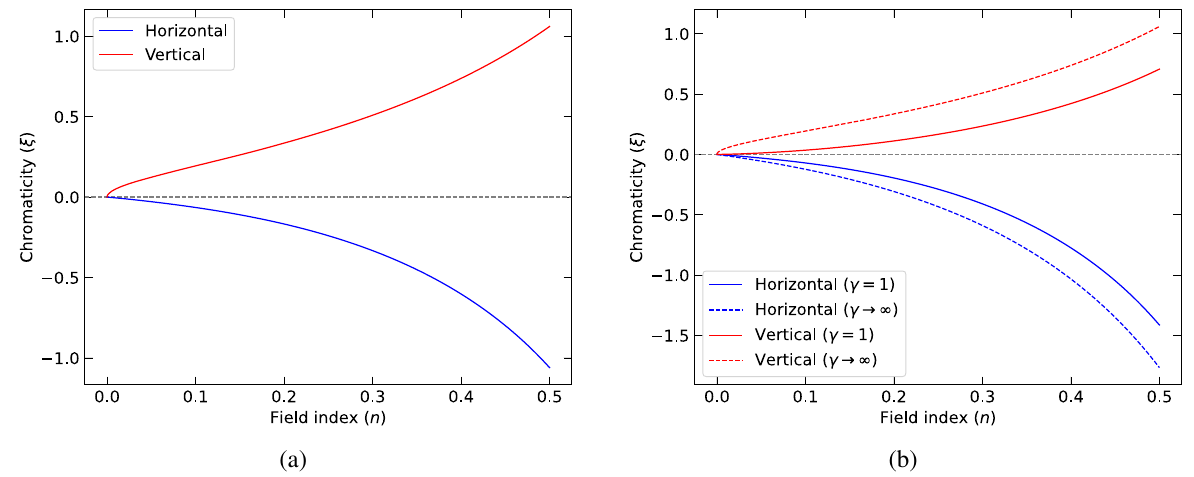
FIG. 1. Analytic approximations of the transverse chromaticities as a function of field index in weak magnetic or electric focusing storage rings. In contrast to the magnetic focusing ring, the chromaticities depend on the momentum in the electric focusing ring. (a) Magnetic focusing case. (b) Electric focusing case. The solid lines indicate the low momentum limit ð γ ¼ 1 Þ and the dashed lines indicate the high momentum limit ð γ → ∞ Þ .